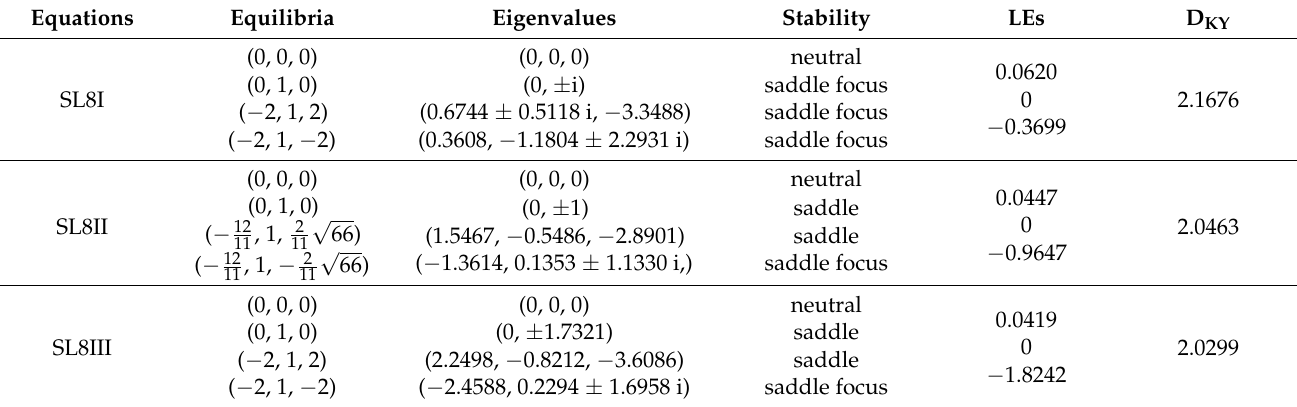
Table 1. Equilibrium points and their stability, Lyapunov exponents and Kaplan-York